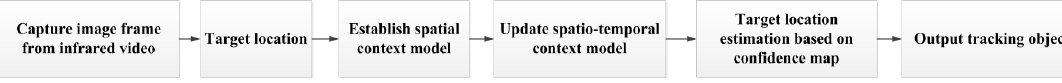
Figure 6. Basic principle of the spatio-temporal context (STC) tracking algorithm.